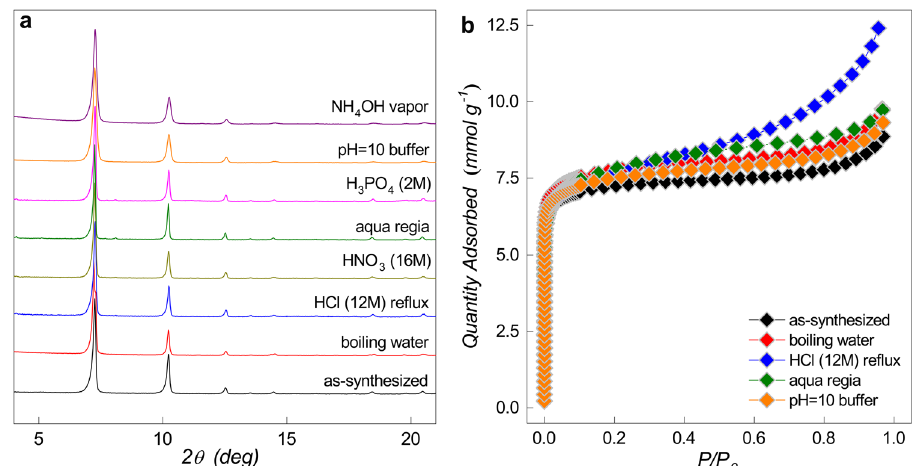
Fig. 2 Chemical stability of MIP-201. a PXRD patterns (CuK α ≈ 1.5406 Å) of MIP-201 samples treated under various chemical conditions. b Nitrogen adsorption isotherms of MIP-201 samples after some typical chemical treatments collected at 77 K (samples were re fl uxed in water before thermal activation at 120 °C for each condition).